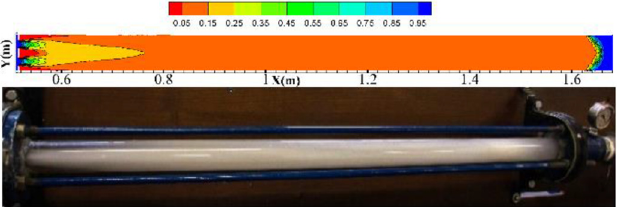
Fig. 17. Comparison of the numerical and experimental results of cavitation length in a same fl ow of 26 m 3 /h through a multi-hole ori